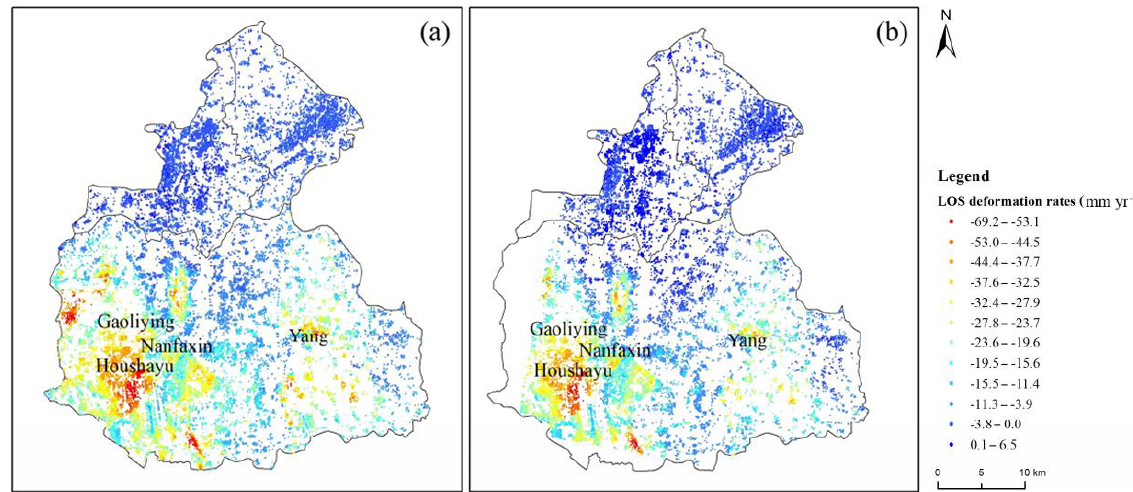
Figure 2. Deformation rates along LOS derived from (a) ascending data (December 2014 to December 2017) and (b) descending data (June 2015 to January 2018).